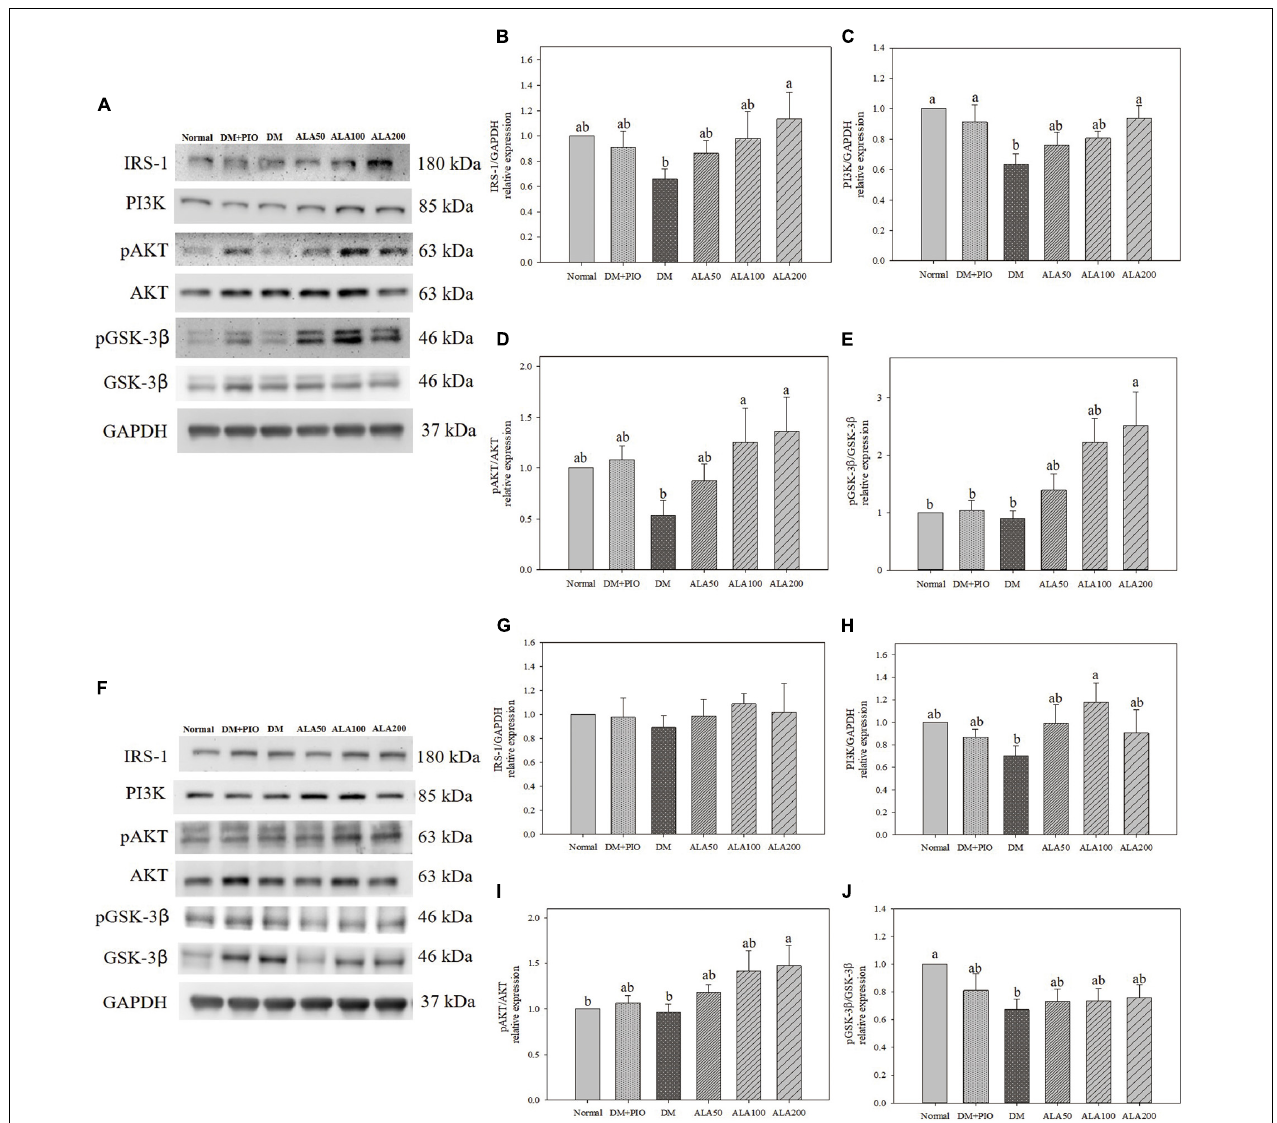
FIGURE 2 | Protein expression levels of the hippocampus (A) and cortex (F) in quantifying relative IRS-1 (B,G) , PI3K (C,H) , pAKT/AKT (D,I) , and pGSK-3 β /GSK-3 β (E,J) in high-fat diet and streptozotocin-induced type 2 diabetic rats treated with alpha-lipoic acid for 13 weeks. Normal, Normal diet; DM, high-fat diet (HFD; 60% fat) with STZ (30 mg/kg body weight, i.p.) induced diabetic rats; DM + Pio, DM rats gavaged with pioglitazone (30 mg/kg body weight) for 13 weeks; DM + ALA50, DM rats gavaged with ALA (50 mg/kg body weight) for 13 weeks; DM + ALA100, DM rats gavaged with ALA (100 mg/kg body weight) for 13 weeks; DM + ALA200, DM rats gavaged with ALA (200 mg/kg body weight) for 13 weeks. Values were calculated as the mean ± SEM, n = 6 for each group. a,b letters indicate significant differences among all samples tested ( p <